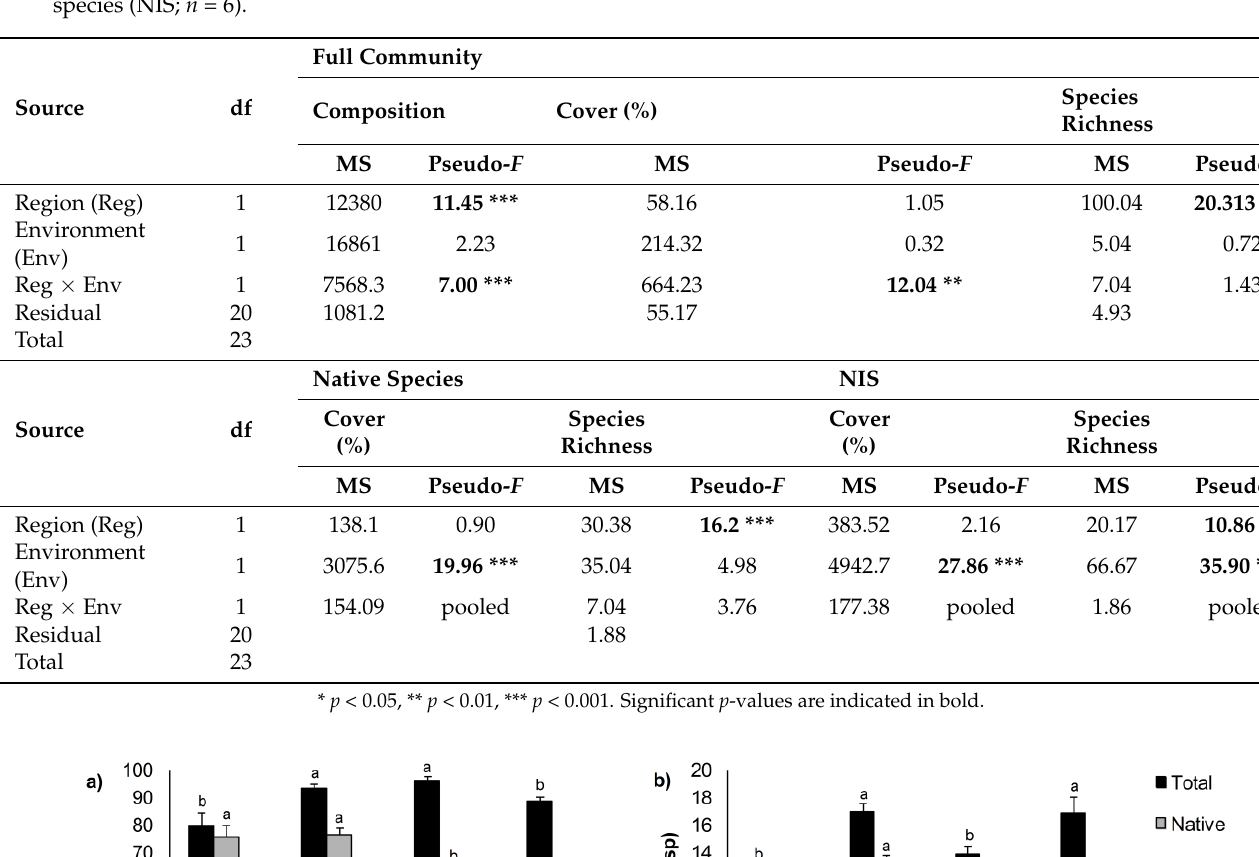
Table 2. Results of 2-way PERMANOVA testing for variability in fouling community composition, and 2-way permutational ANOVA examining changes in percent cover and species richness of total community, native species, and non-indigenous species (NIS; n = 6).